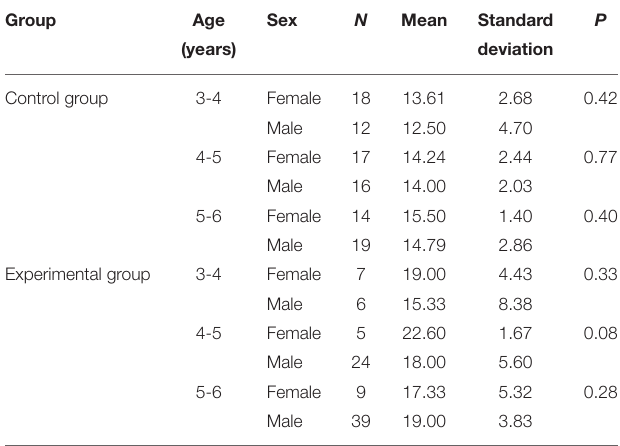
TABLE 6 | Effect of sex on children’s jumping motor performance.